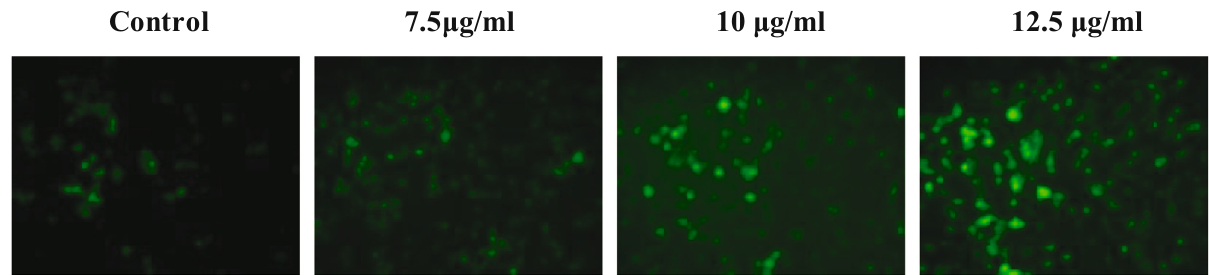
Figure 9: E ff ect of ZnO NPs on the intracellular ROS generation in MDA - MB - 231 cells.